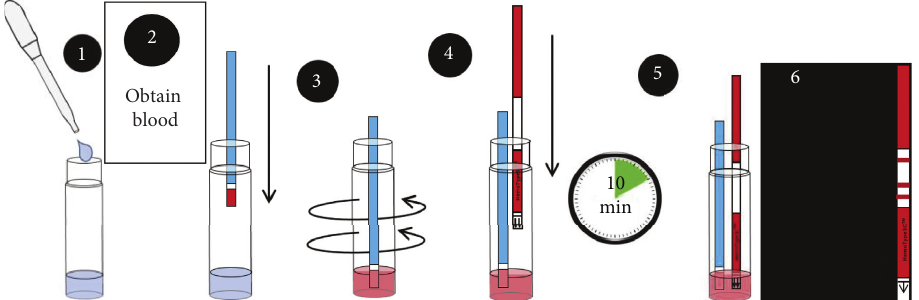
Figure 1: HemoTypeSC ™ test running